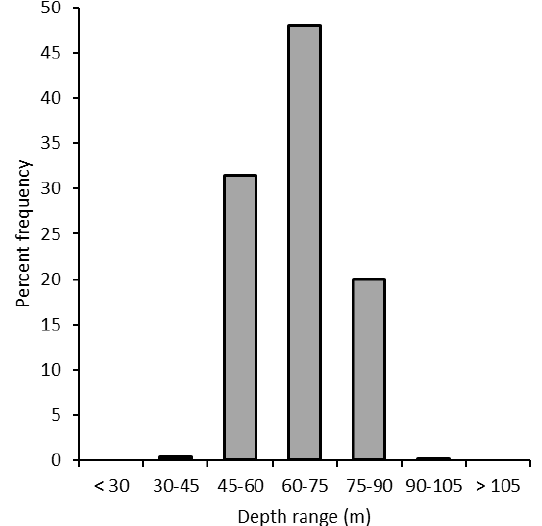
Figure 3. Sites in the three explored macro-areas (A1, Eastern Liguria; A2, Central Liguria; A3, Western Liguria) were sorted according to decreasing order of recorded mean density ( ± SE).